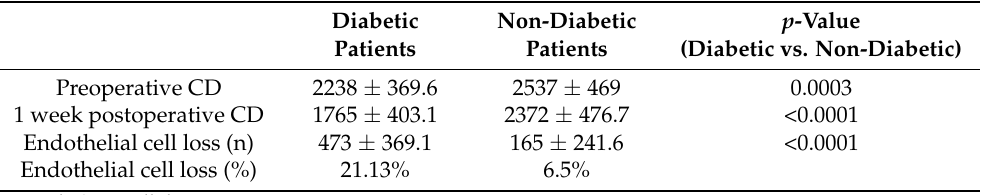
Figure 5. Correlation matrix between measured variables before the surgery. Legend: AXL, axial length; ACD, anterior chamber depth; CCT_PRE, central corneal thickness preoperative; CD_PRE, cell density preoperative; HEX_PRE, hexagonality of endothelial cells preoperative; * significance, p < 0.05.